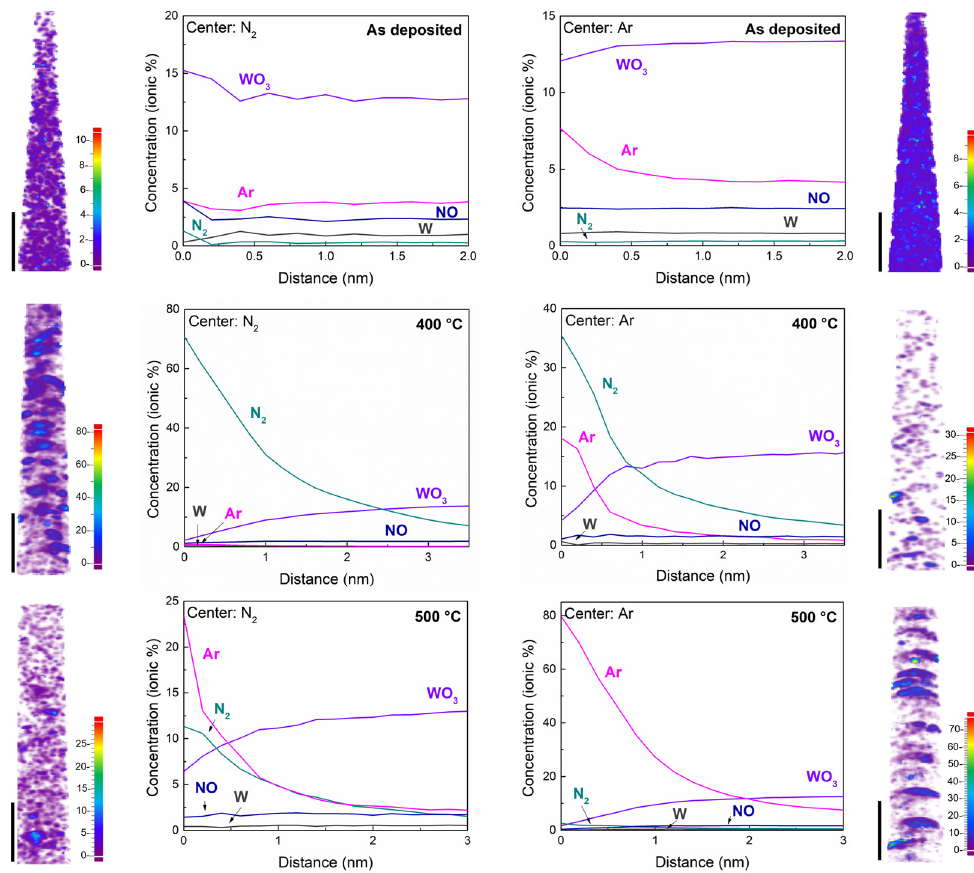
Figure 5. Radial distribution function (RDF) and heatmaps for cluster analysis of Ar and N 2 in WO 3 thin films as deposited and annealed at 400 °C and 500 °C in a forming gas (3% H 2 /N 2 ).